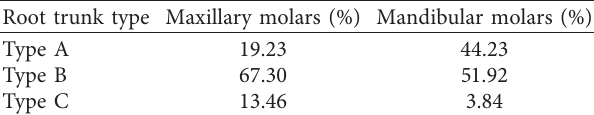
and LIRS: lingual interradicular space. Table 4: Distribution of root trunk type in maxillary and man- dibular